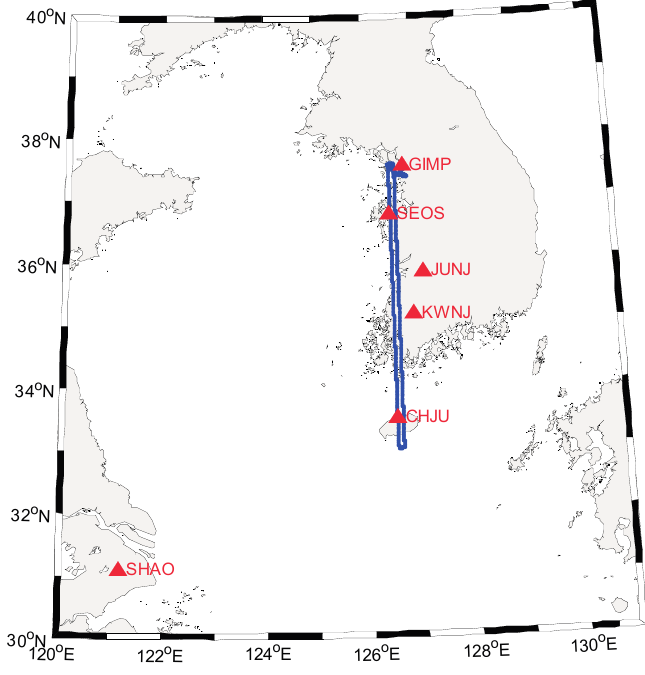
Figure 1. Ground track of aircraft and locations of